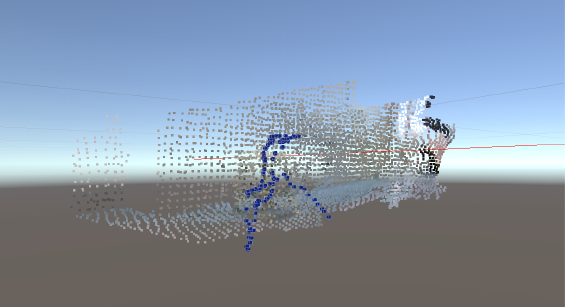
Figure 7. Final complete 3D reconstruction results, including the overall environmental model and the camera track in Unity 3D.